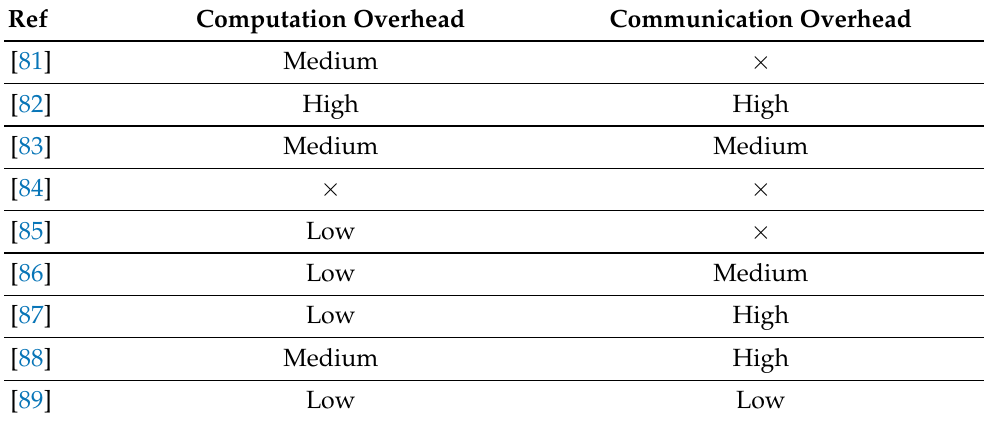
Table 4. VANETs location privacy schemes used in different